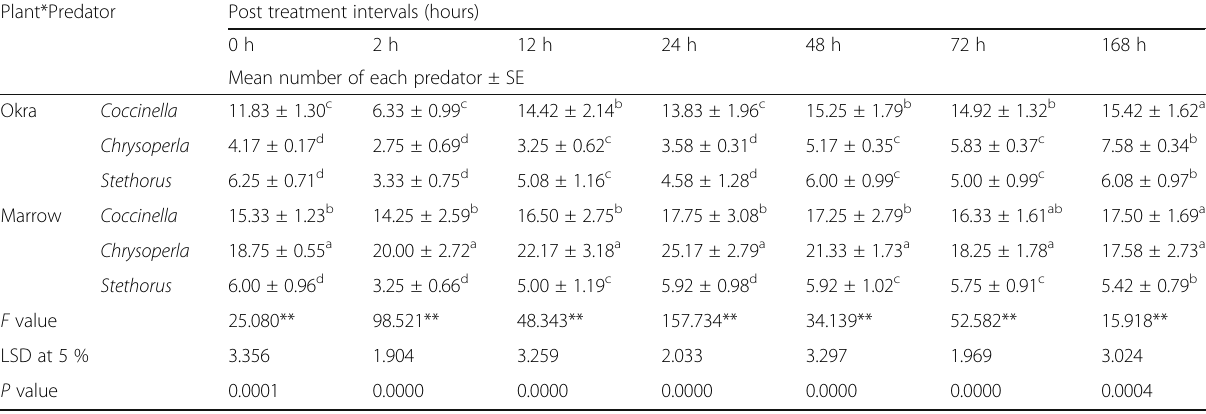
Table 2 Interaction of two factors (Plant*Predator) with respect to the adult predators abundance Plant*Predator